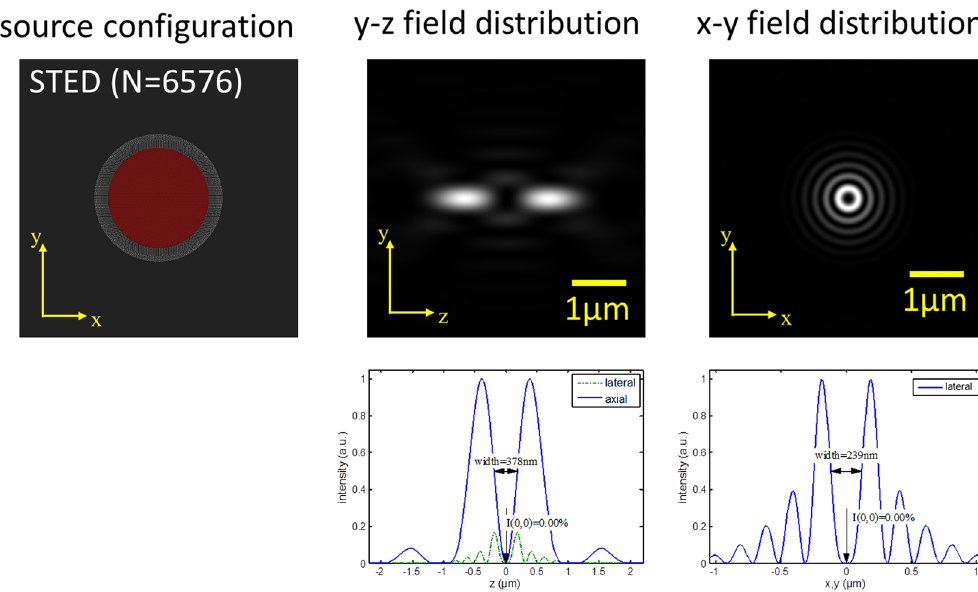
Figure 9. Concept for stimulated fluorescence emission depletion. Left: z-projection of the arrangement of N = 6,576 coherent light sources (e.g. glass fibers with low NA) directed towards the origin. Sources are distributed within a solid angle of π θ π Ω = − . ~ 2 (1 cos ) 1 25 (This corresponds to an objective lens with NA = 1.4). Center: y-z section across the intensity distribution around the origin. The width given (left: 378 nm, right: 293 nm) refers to the FWHM of the respective minimum (along the z- or x,y-axis). Right: x-y section across the intensity distribution around the origin. For STED-type illumination, half of the sources in the center were phase-delayed by π (highlighted in